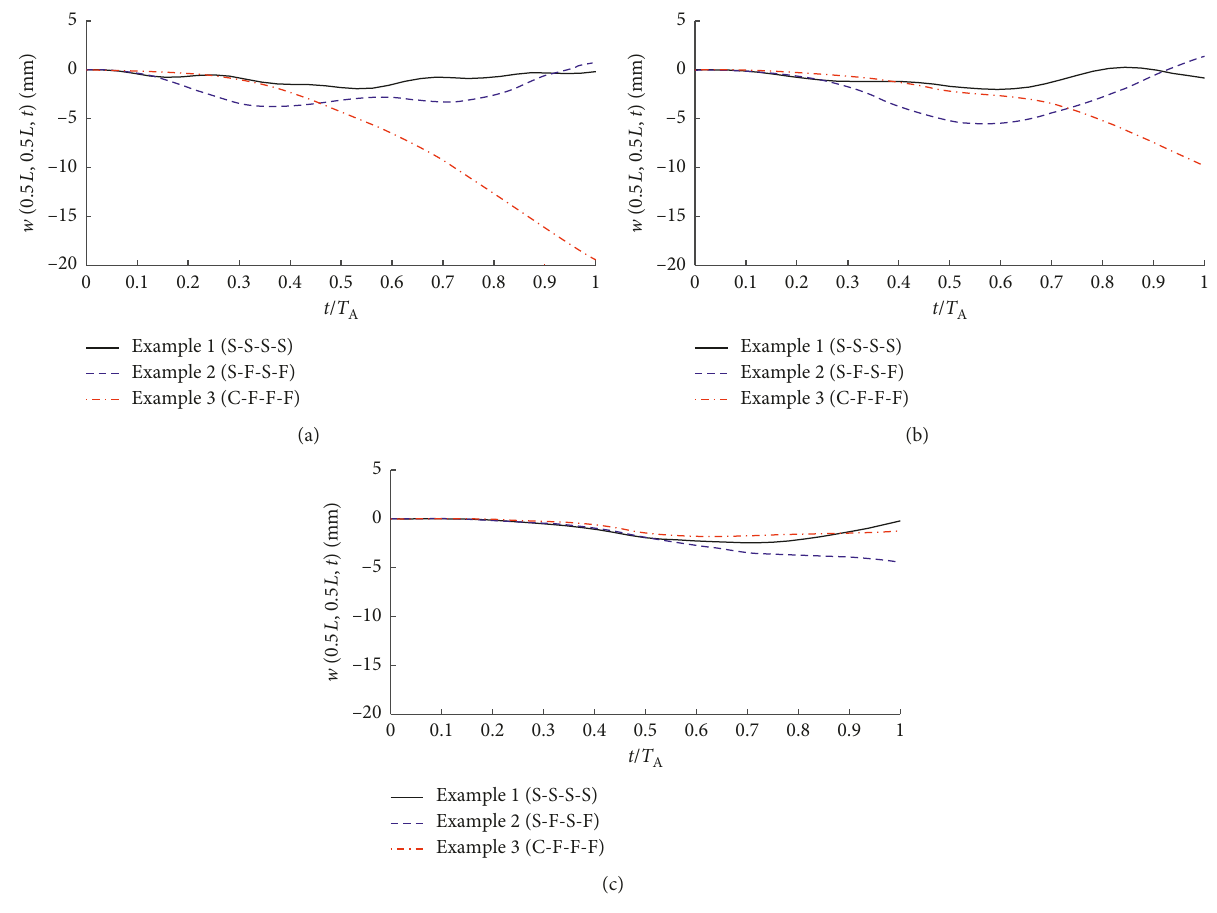
Figure 18: Effects of boundary conditions and moving speed v a moving point force travels along the trajectory given by Case 3 of (39). (a) v 0